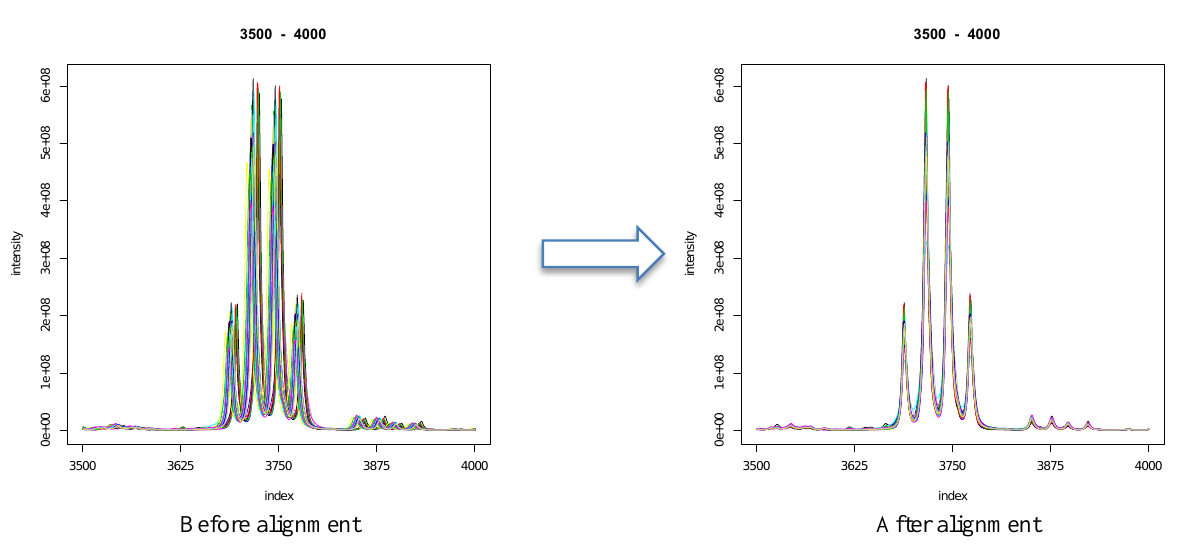
Figure 2. Example of a spectral region before and after alignment using CluPA [8]. The example comes from the Wine dataset